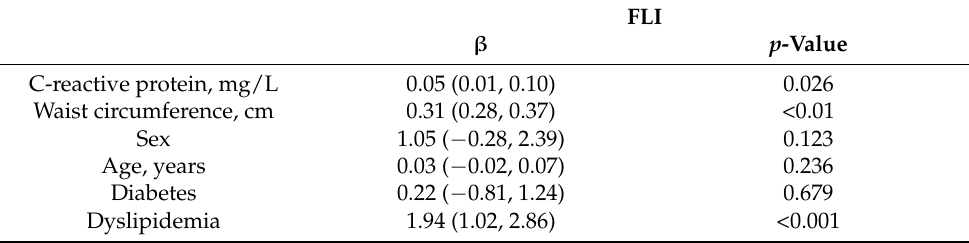
Figure 2. Schematic representation of our main results. Abbreviations: NAFLD, non-alcoholic fatty liver disease; NASH, non-alcoholic steatohepatitis; FLI, Fatty Liver Index; BARD, BMI, AST/ALT ratio, and presence of diabetes. Parts of the figure were adapted with permission from von-Hafe and Borges-Canha et al. [19], and parts were drawn by using pictures from Servier Medical Art (licensed under a Creative Commons Attribution 3.0 Unported License; https://creativecom- mons.org/licenses/by/3.0/, accessed on 28 June 2022). Concerning the anthropometric analysis, our results are in accordance with some previous studies performed in other populations. Sabir et al. also described a positive as- sociation between hepatic steatosis and waist circumference and waist-to-hip ratio in pa- tients with obesity [20]. This was also true for lean, overweight, and obese patients studied by Shao et al., and for lean subjects studied by a meta-analysis by Sookoian [21,22]. An